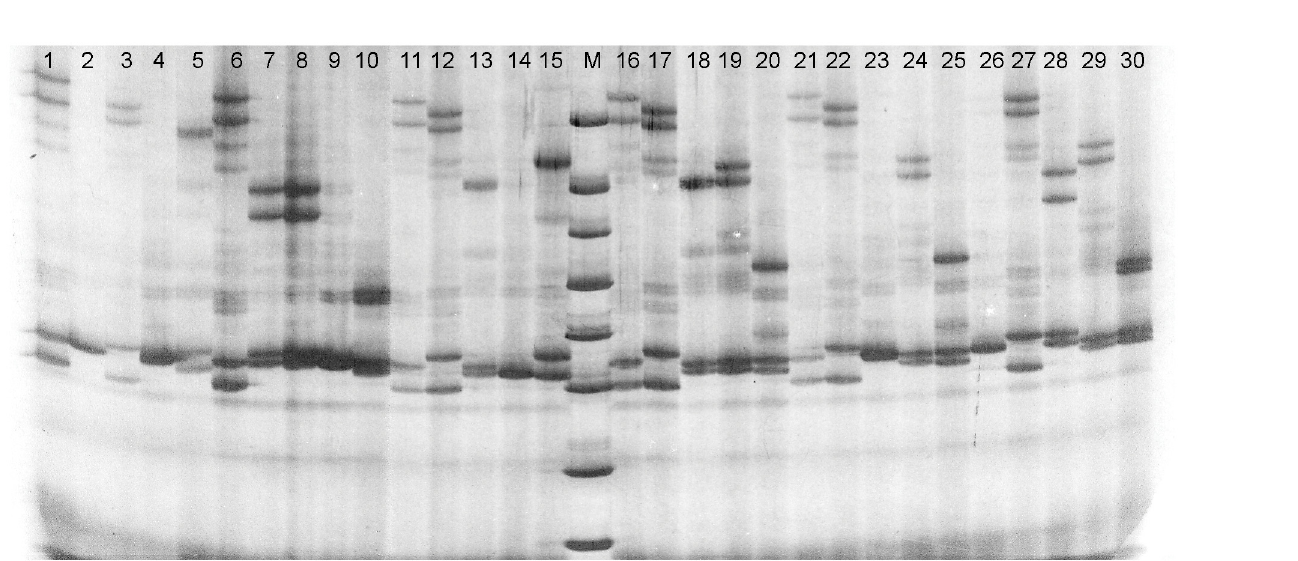
PLOS ONE | DOI:10.1371/journal.pone.0149414 February 29,